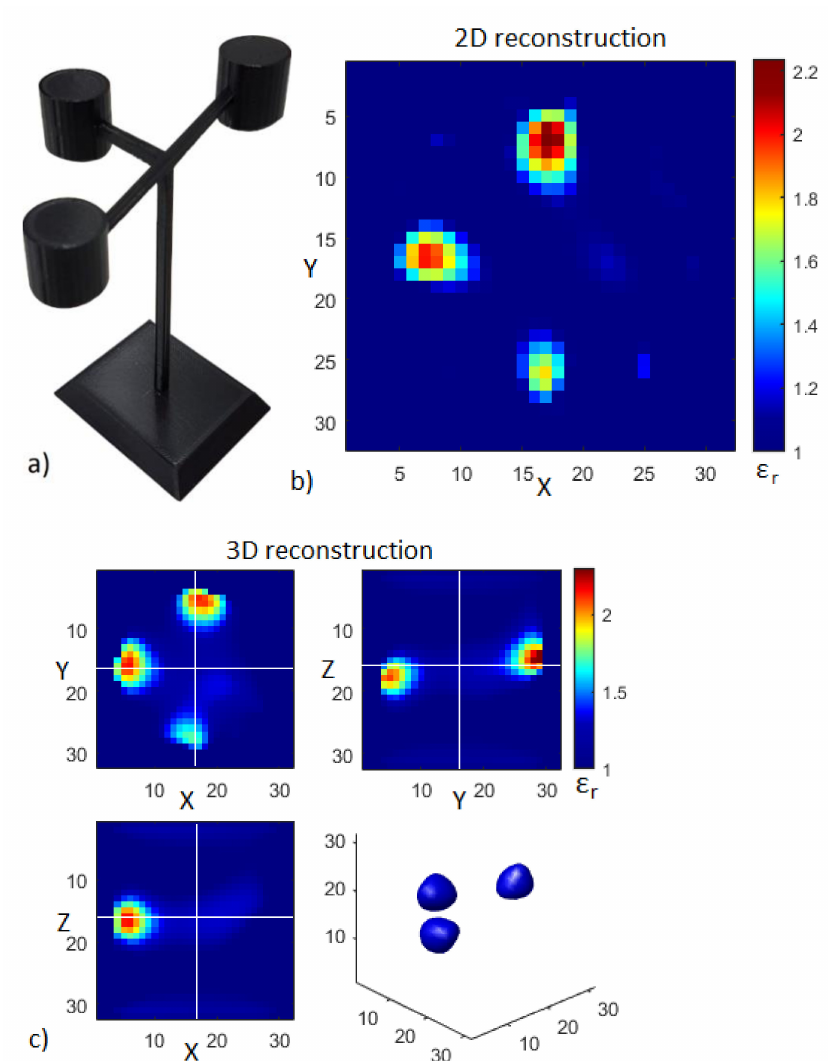
Figure 13. ( a ) 3D printed test object of PLA (relative permittivity 2.75). ( b ) 2D images reconstructed using the Landweber iterative algorithm. ( c ) Slices of 3D volume reconstructed using the Landweber algorithm. Crosshair markers show the mutual position of slices. The segmentation result is shown by surface